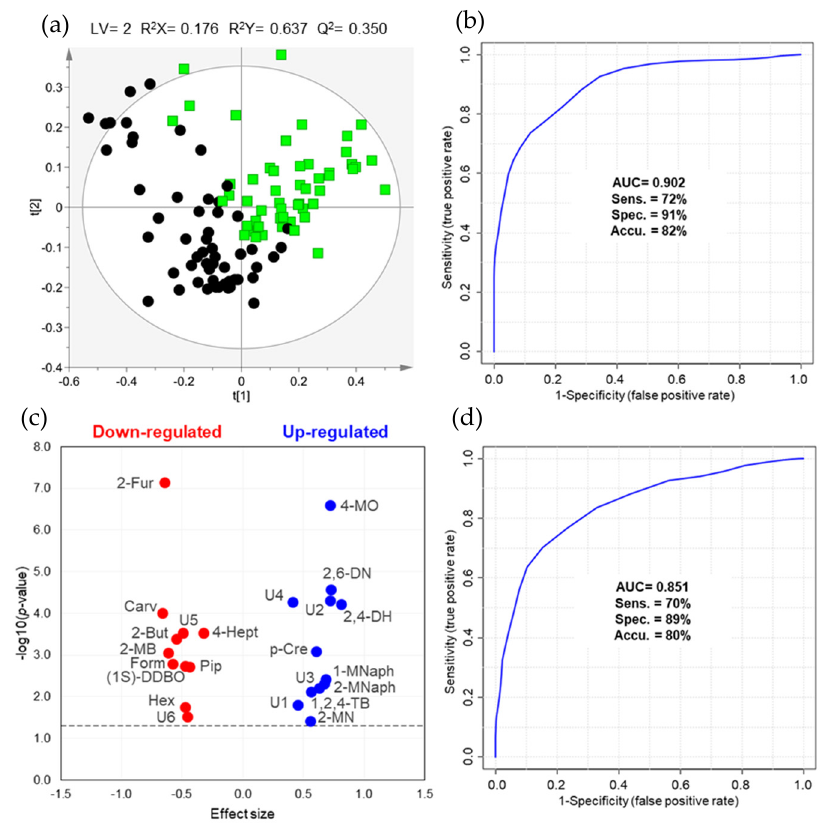
Figure 1. ( a ) PLS-DA scores scatter plot and ( b ) receiver operating characteristic (ROC) curve ob- tained for urinary volatile profile (VOCs and VCCs concatenated matrix), after variable selection (109 observations × 4184 variables), of BC patients (green squares, n = 53) and cancer-free controls (black circles, n = 56). ( c ) Volcano plot representing the set of twenty-three urinary volatile metabolites changing between BC patients and cancer-free controls. ( d ) ROC curve obtained for the set of seventeen discriminant volatiles (109 observations × 17 metabolites) that were formally (L1) and putatively (L2) identified. Metabolite abbreviations: 1-MNaph, 1-methylnaphthalene; (1S)-DDBO, (1S)-1,5-dimethyl-6,8-dioxabicyclo[3.2.1] octane; 1,2,4-TB, 1,2,4-trimethylbenzene; 2-But, 2-butanone; 2-Fur, 2-furaldehyde; 2-MB, 2-methylbutanal; 2-MN, 2-methylnonane; 2-MNaph, 2-methyl-